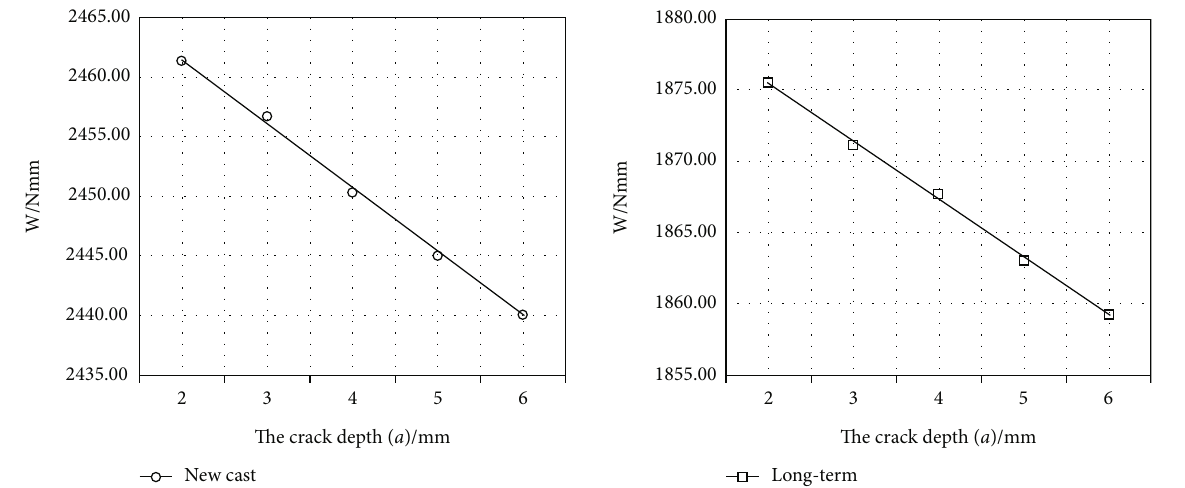
Figure 9: The W - a curves of the new cast and the long-term stored propellant specimens.